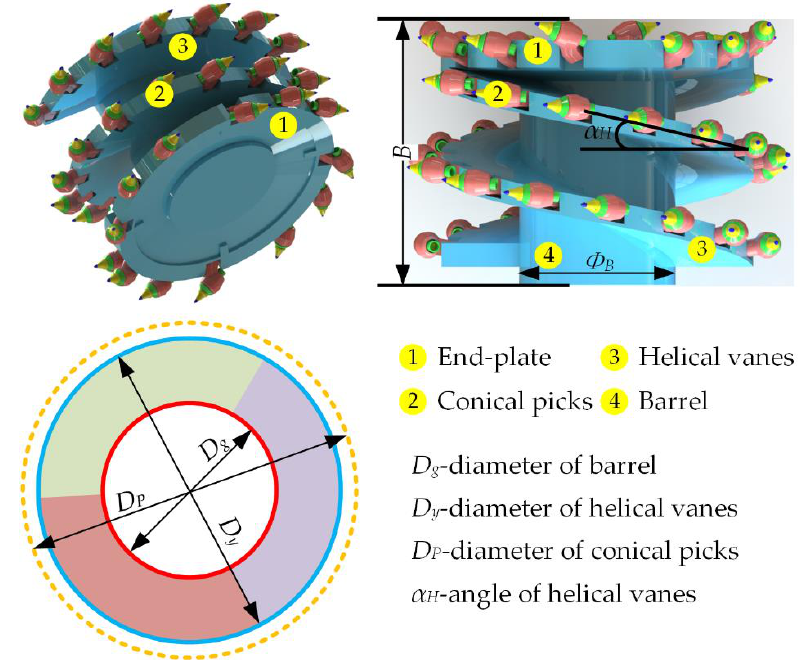
Figure 1. Main structures of cutting drum of shearer.